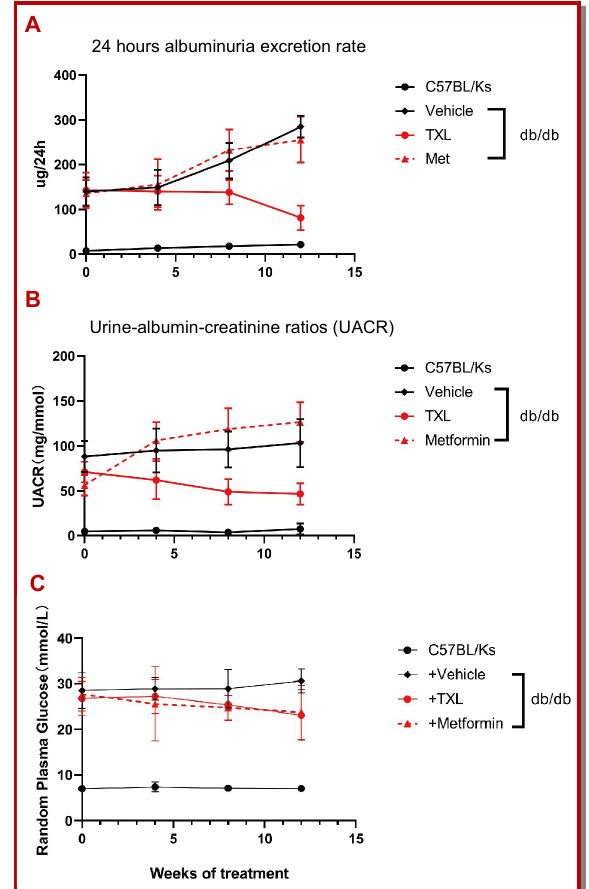
Figure 1: Effect of intervention with Tongxinluo (TXL) on albu- minuria and renal function in the animal model of diabetic kidney diseases. Dynamic changes in urinary albumin excre- tion of mice in 24 hours every 4 weeks (n=11) (A) ; Dynamic changes in urine protein creatinine ratio (UACR) from the start of Tongxinluo and metformin intervention to the end of the experiment (n=11) (B); Random plasma glucose levels of the intervention mice as indicated were measured every 4 weeks (n=11) (C)